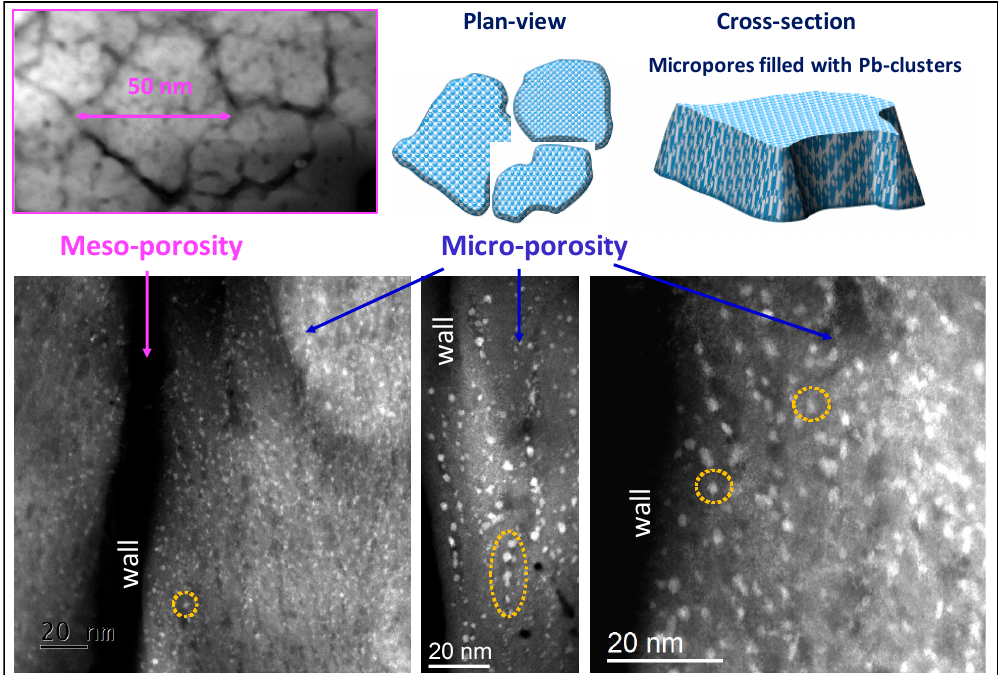
Figure 6. Scanning transmission electron microscopy images of the TiO 2 –MAPbI 3 blend after degradation of the perovskite to PbI 2 and Pb aggregation. Pb nanoclusters are used as markers to trace the initial distribution of the perovskite into the micro-pores (some of them are circled in yellow).